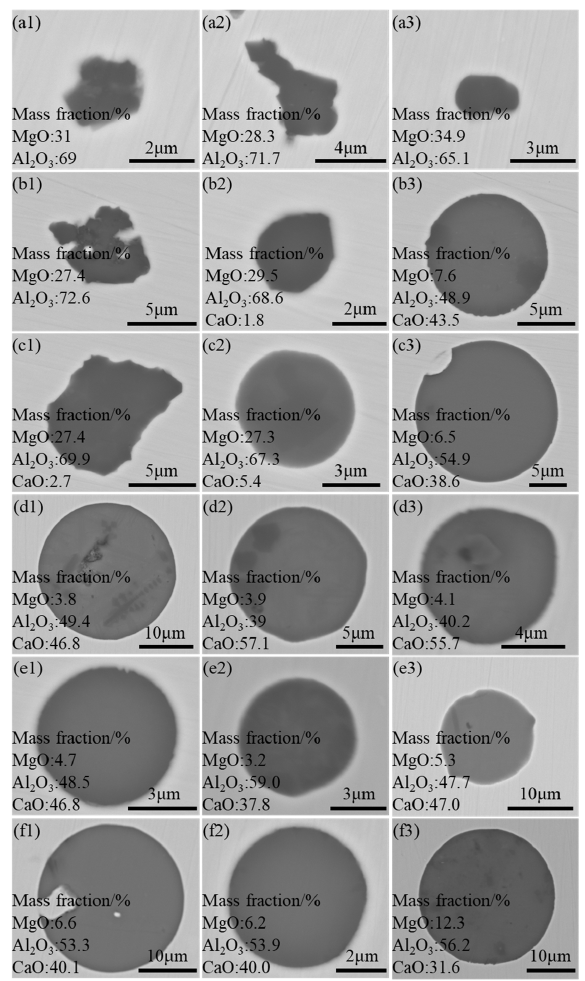
Figure 2. Morphology and composition of typical inclusions encountered in samples: ( a1 ) a MgO-Al 2 O 3 inclusion in sample 1; ( a2 ) a MgO-Al 2 O 3 inclusion in sample 1; ( a3 ) a MgO-Al 2 O 3 inclusion in sample 1; ( b1 ) a MgO-Al 2 O 3 inclusion in sample 2; ( b2 ) a CaO-MgO-Al 2 O 3 inclusion in sample 2; ( b3 ) a CaO-MgO-Al 2 O 3 inclusion in sample 2; ( c1 ) a CaO-MgO-Al 2 O 3 inclusion in sample 3; ( c2 ) a CaO-MgO-Al 2 O 3 inclusion in sample 3; ( c3 ) a CaO-MgO-Al 2 O 3 inclusion in sample 3; ( d1 ) a CaO-MgO-Al 2 O 3 inclusion in sample 4; ( d2 ) a CaO-MgO-Al 2 O 3 inclusion in sample 4; ( d3 ) a CaO-MgO-Al 2 O 3 inclusion in sample 4; ( e1 ) a CaO-MgO-Al 2 O 3 inclusion in sample 5; ( e2 ) a CaO-MgO-Al 2 O 3 inclusion in sample 5; ( e3 ) a CaO-MgO-Al 2 O 3 inclusion in sample 5; ( f1 ) a CaO-MgO-Al 2 O 3 inclusion in sample 6; ( f2 ) a CaO-MgO-Al 2 O 3 inclusion in sample 6; ( f3 ) a CaO-MgO-Al 2 O 3 inclusion in sample 6.